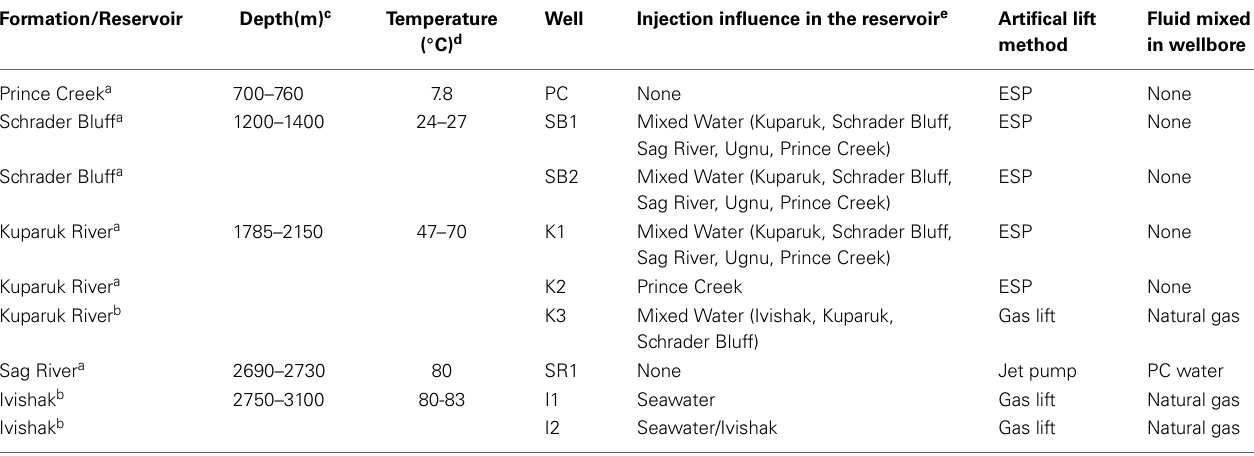
Table 1 | Formation physical characteristics, produced water lift method, and fluid mixing for Milne Point and Prudhoe Bay (Alaskan North Slope) oil field